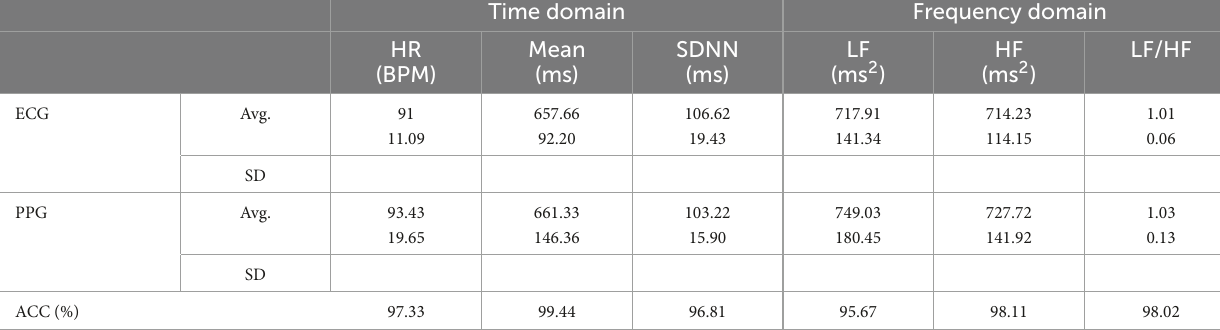
TABLE 1 Accuracy comparison between ECG and PPG signals in terms of time domain and frequency domain parameters.